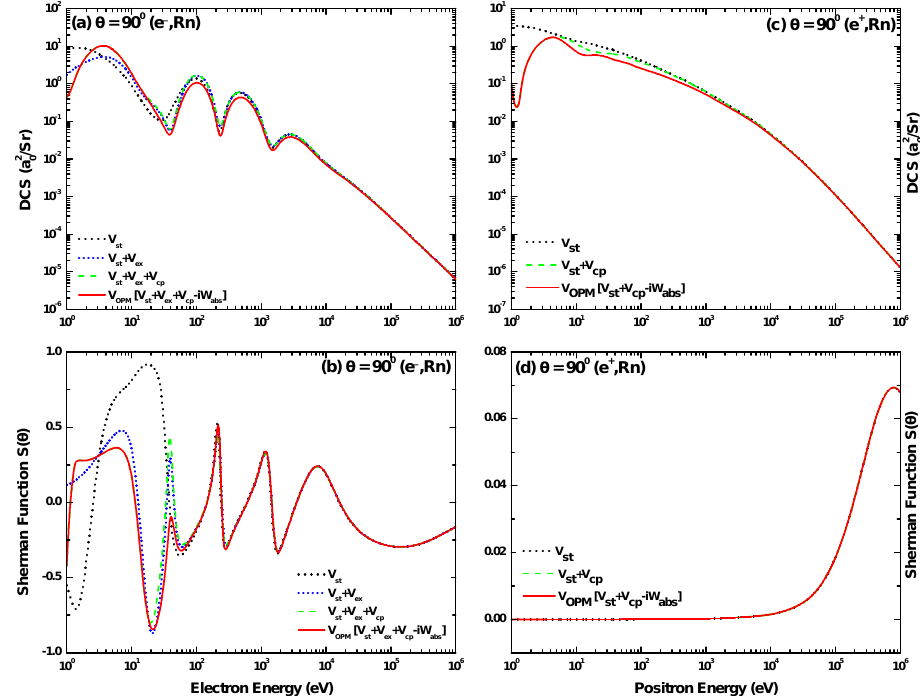
Figure 2. Energy dependence of ( a , c ) the DCS and ( b , d ) the Sherman function S ( θ ) for electron ( a , b ) and positron ( c , d ) impact on 222 Rn at a scattering angle of 90 ◦ . Shown are the results ( · · · · · · , black) from V st ; ( · · · · · · , blue) from V st + V ex ; ( − − −− , green) from V R = V st + V ex + V cp and V R = V st + V cp , respectively, for electron and positron projectiles; and (——, red) from V opt = V st + V ex + V cp − iW abs for electron scattering and V opt = V st + V cp − iW abs for positron scattering,